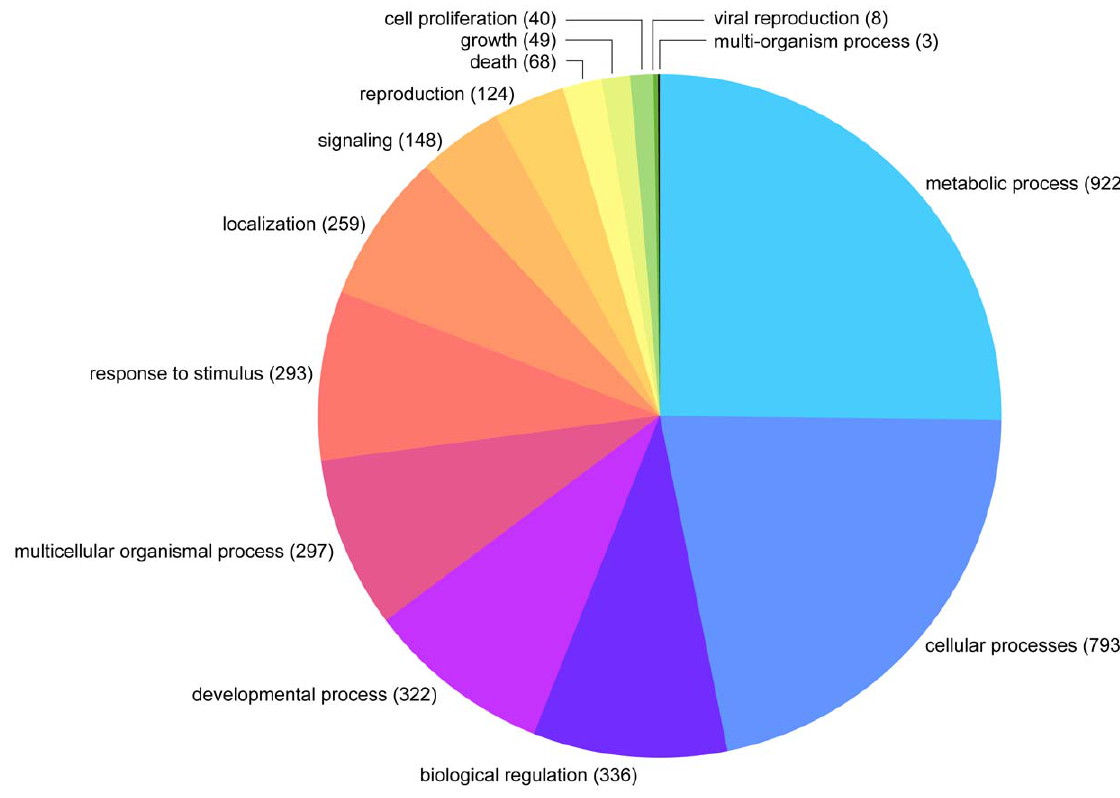
Figure 2. Distribution of the medfly TAG assembled sequences in Gene Ontology Biological Process categories Level II.